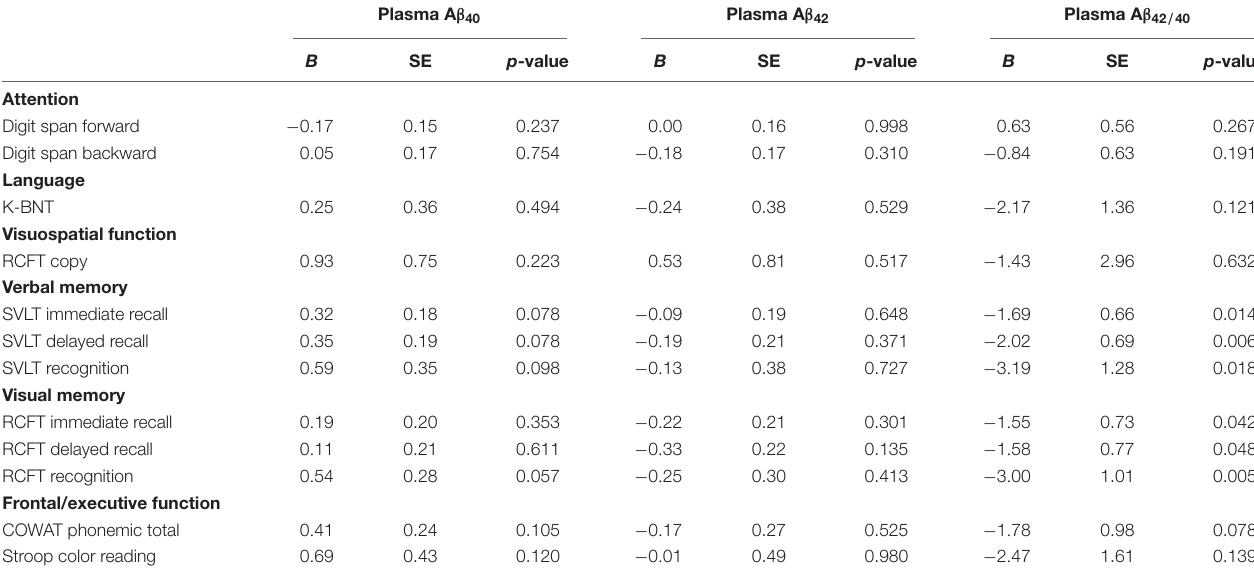
TABLE 4 | Correlations of plasma A β 40 , A β 42 , and A β 42 / 40 levels with the results of neuropsychological